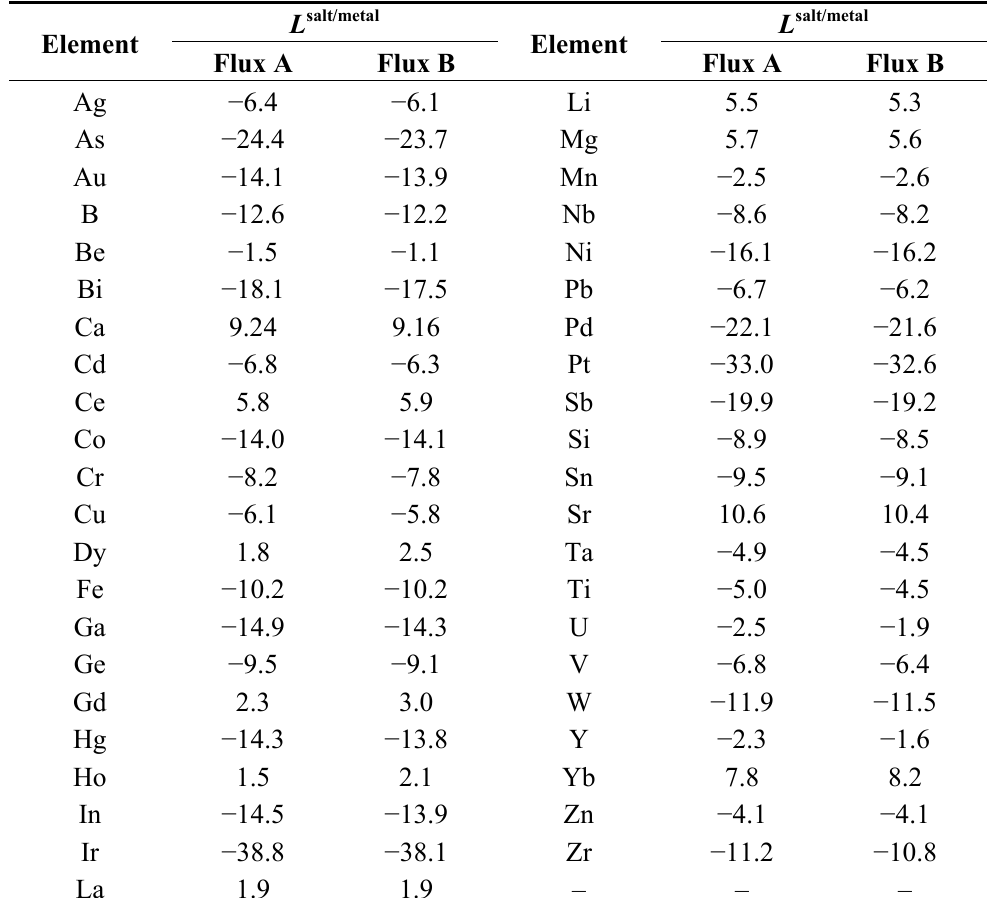
Table 1. Distribution ratio of elements between salt flux (chloride) and metal phases by using flux A or